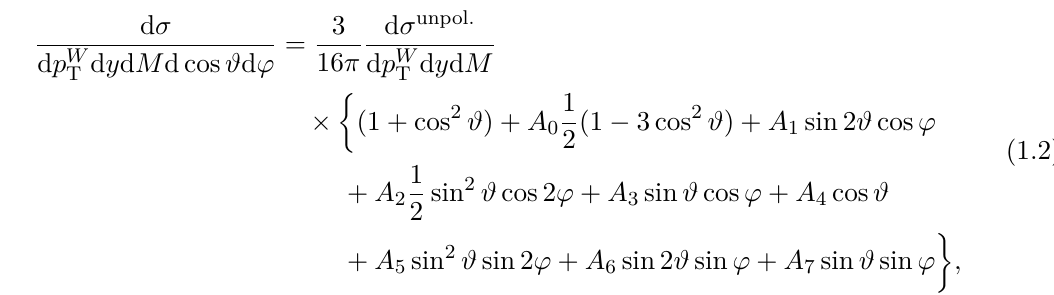
Figure 1 . Muon q/p T distribution in simulated W → µν events with variations in (left) m W and (right) the A coefficient. The dashed vertical lines indicate the two p 3 the m W